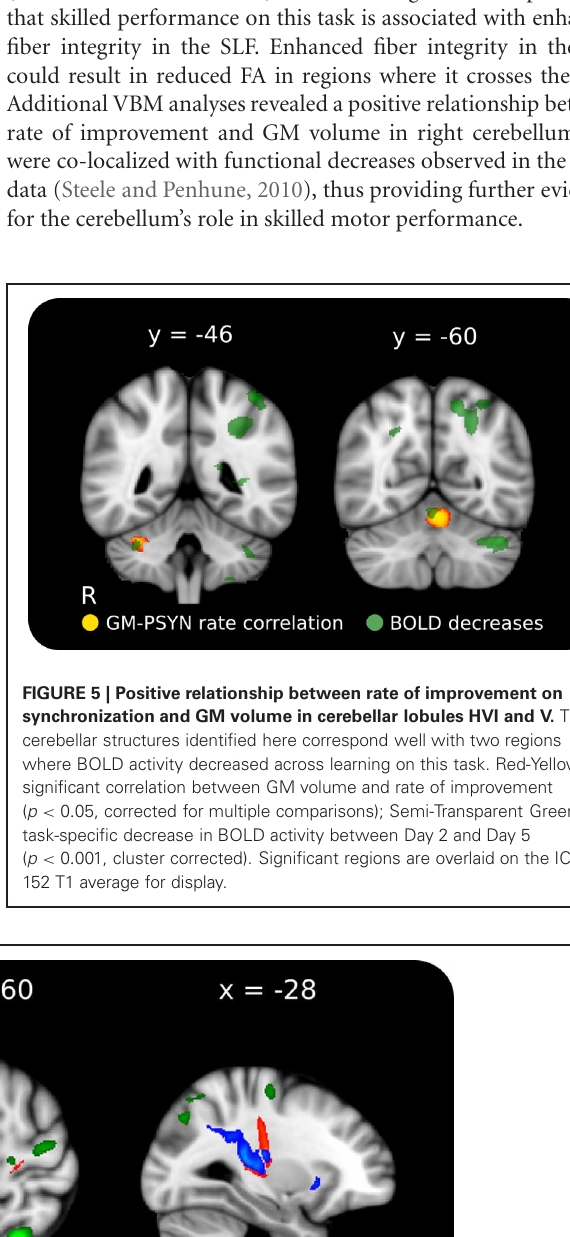
the laterally projecting fibers can be clearly seen. Tractography was conducted on each individual, averaged, and thresholded at 10% of maximum for display. Lighter colors indicate higher particle count. The tractography seed mask contained all voxels in the skeleton that showed a significant negative correlation between FA and final PSYN performance in both hemispheres. Tracts have been overlaid on the ICBM 152 T1 average for